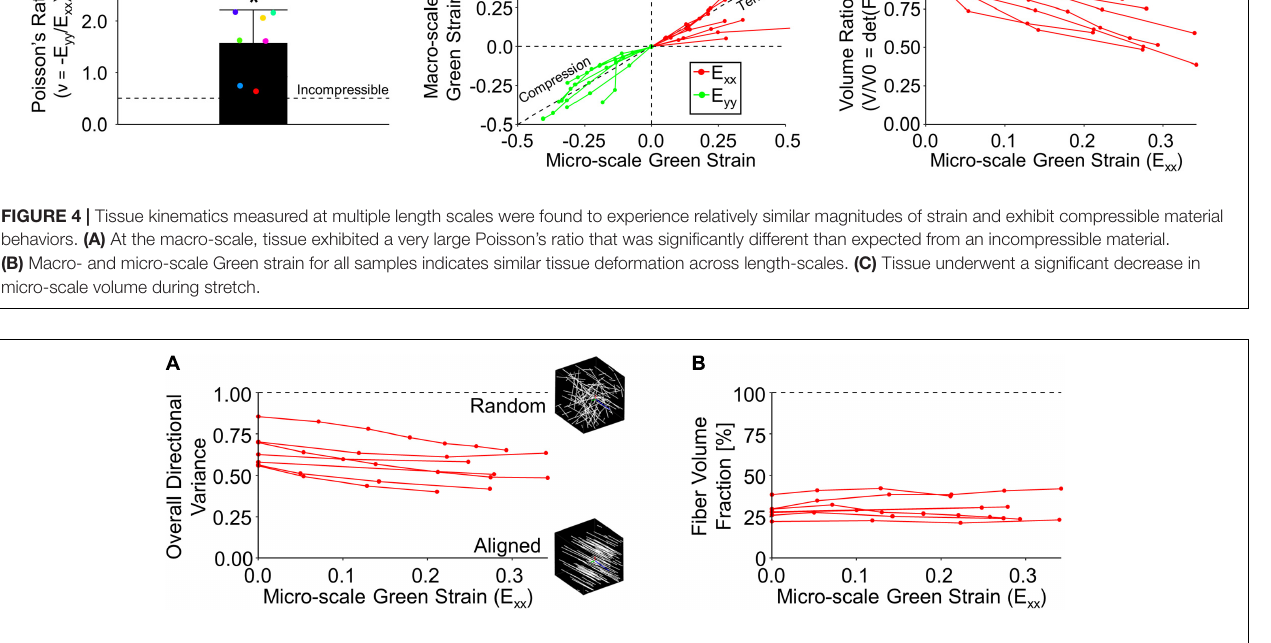
FIGURE 5 | Collagen fiber directional variance decreased during stretch (A) , indicating increased alignment, but fiber volume fraction did not significantly change (B) .